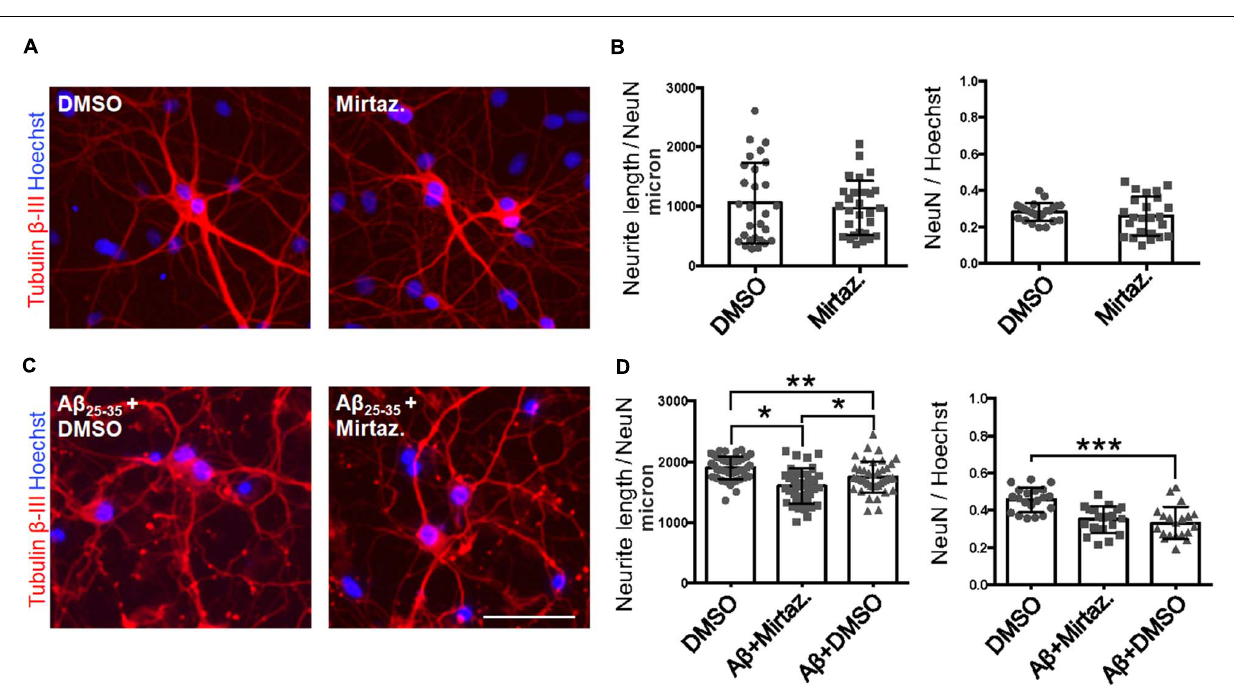
FIGURE 7 | Rescue of A β -induced dendritic atrophy by mirtazapine treatment. (A) Representative microscopy images (10X) of DIV7 hippocampal neurons after 24-h treatment in DMSO (left) or mirtazapine (10 µ M, 4 h right ), stained with anti-Tubulin β -III (red) and Hoechst (blue). Scale bar = 50 µ m. (B) Scatter plot of total neurite length for each neuron ( left ) expressed in µ m/neuron, and neuronal density expressed as the ratio between the number of NeuN positive neurons on the total number of cells ( right ). Each dot represents an image in the different conditions, n = 24–25 fields per condition. (C) Representative images (10X) of DIV7 hippocampal neurons after 24 h of A β + DMSO (left) or A β + mirtazapine treatment (right) , stained with anti-Tubulin β -III and Hoechst. Scale bar = 50 µ m. (D) Scatter plot of neurite length for each neuron (left) expressed in µ m/neuron, and neuronal density expressed as the ratio between the number of neurons on the total number of cells (right) . Each dot represents an image in the different conditions, n = 40–44 fields per condition. Following D’Agostino-Pearson’s normality test, we performed an unpaired two-tailed t -test or one way ANOVA. * p ≤ 0.05; ** p ≤ 0.01; *** p ≤